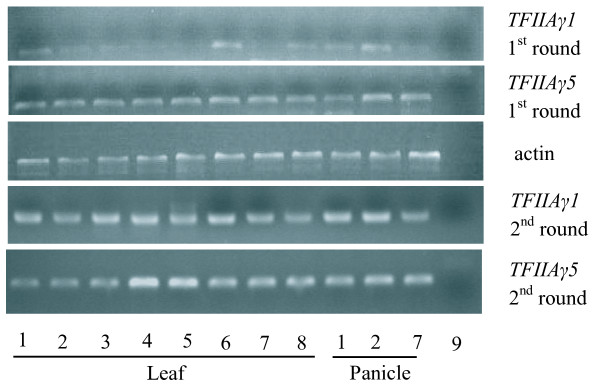
RT-PCR results. 1. Oryza sativa; 2. Oryza punctata; 3. Oryza officinalis; 4. Oryza australiensis; 5. Leersia tisserantti; 6. Hygroryza aristata; 7. Zizania latifolia; 8. Rynchoryza subulata; 9. Blank control.